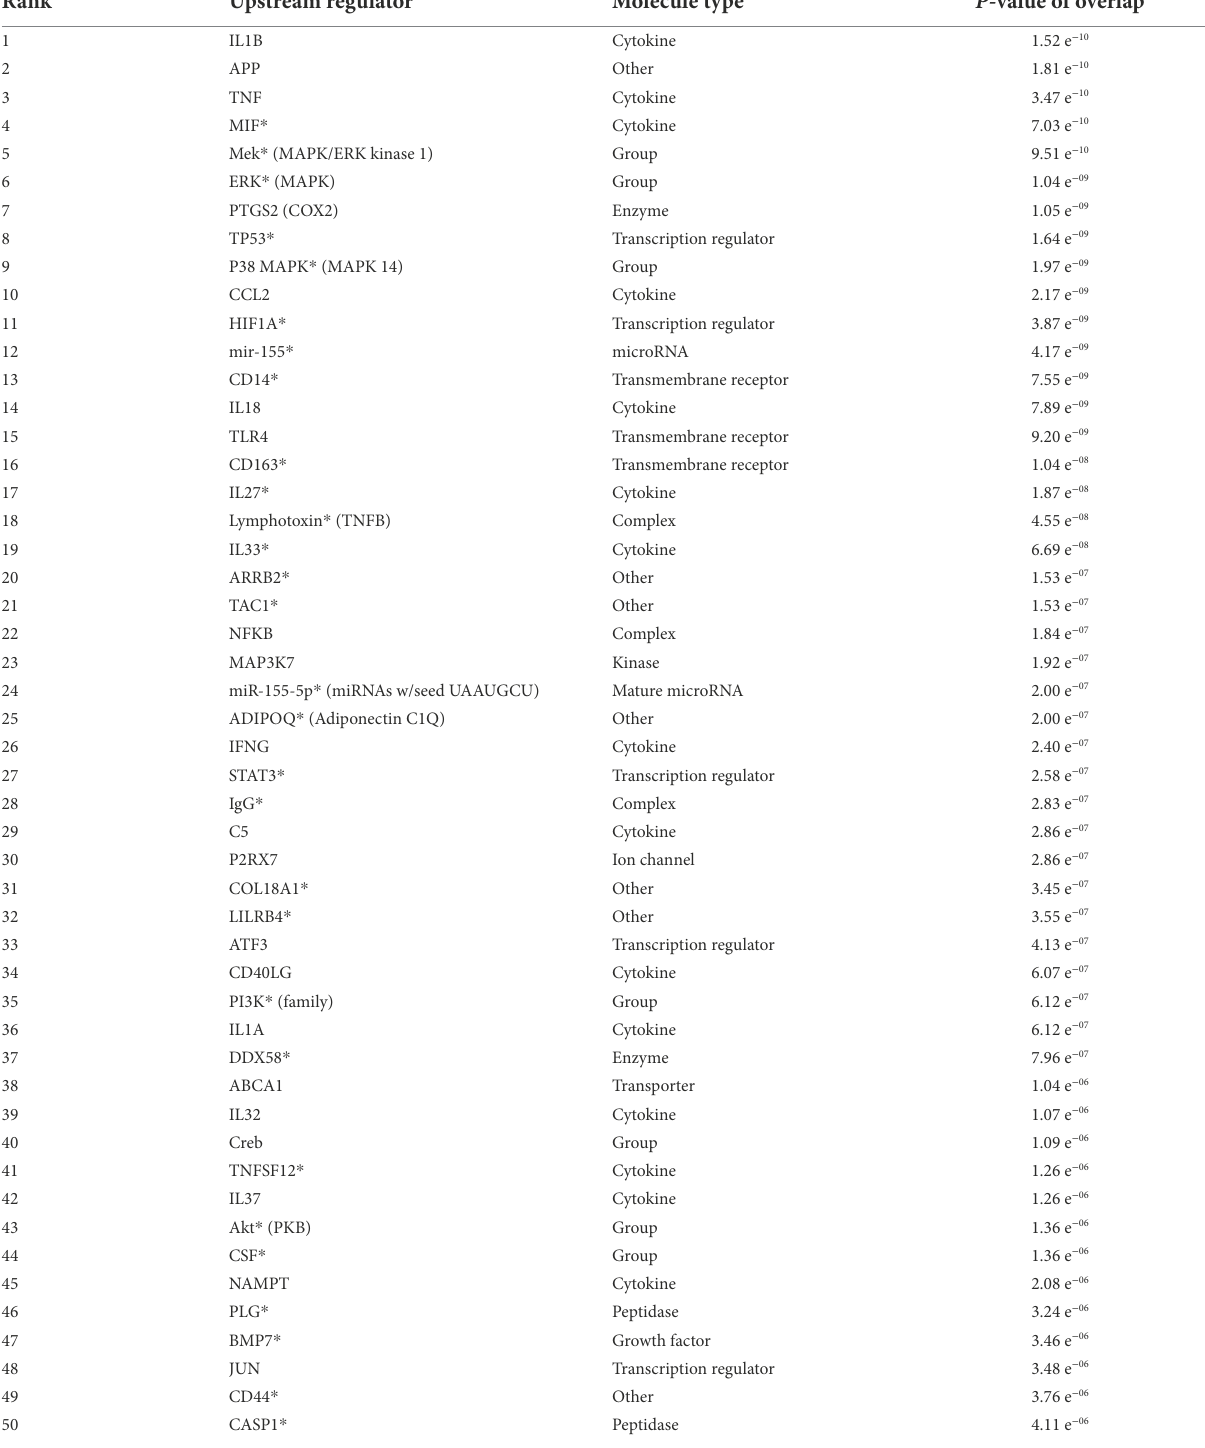
TABLE 1 The upstream regulators of α -synuclein (SNCA) predicted by expression analysis of the α -synuclein NCBI gene dataset using IPA. Rank Upstream regulator Molecule type